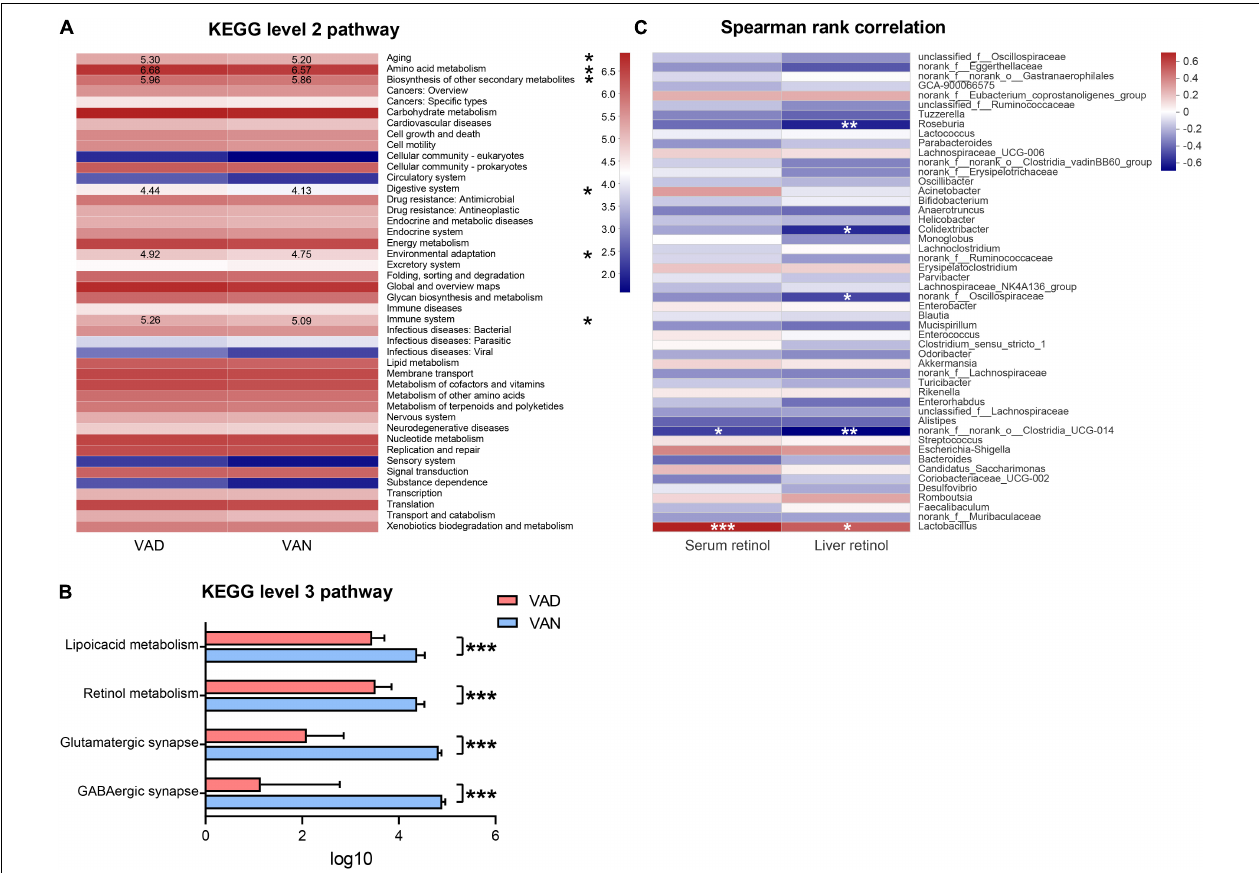
FIGURE 8 | Predicted function of the gut microbiota and its correlation with the liver retinol and serum retinol. (A) Comparisons of the VAD- and VAN-diet impact on the predicted functions of the gut microbiota at the Kyoto Encyclopedia of Gene and Genomes (KEGG) level 2 by using the PICRUSt analysis. The number indicates the logarithmic value of enrichment to the pathways. (B) Significantly different functions of the gut microbiota at KEGG level 3 between the VAN and VAD group as predicted by the PICRUSt analysis (partial). (C) Correlation of the liver retinol and the serum retinol with the relative abundance of the top 50 bacterial genera in all mice. The red color represents a positive correlation. Blue color represents a negative correlation. VAD, vitamin A deficiency diet; VAN, vitamin A normal diet. n = 10 per group. ∗ P < 0.05, ∗∗ P < 0.01, and ∗∗∗ P < 0.001.